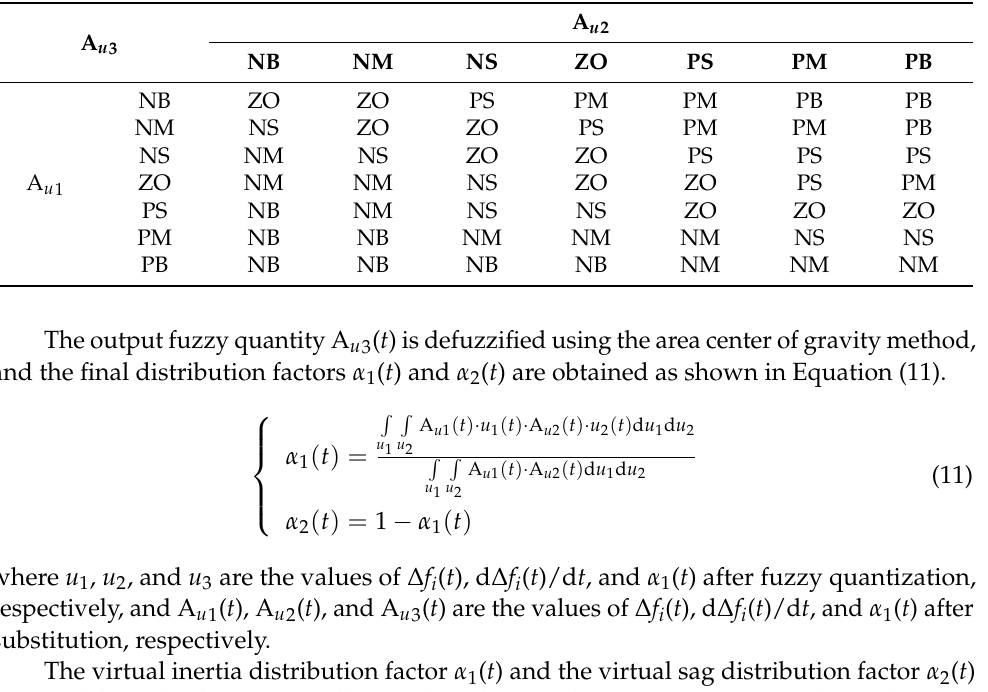
Figure 4. Three-dimensional relationship between inputs and output. Table 2. Fuzzy control rules